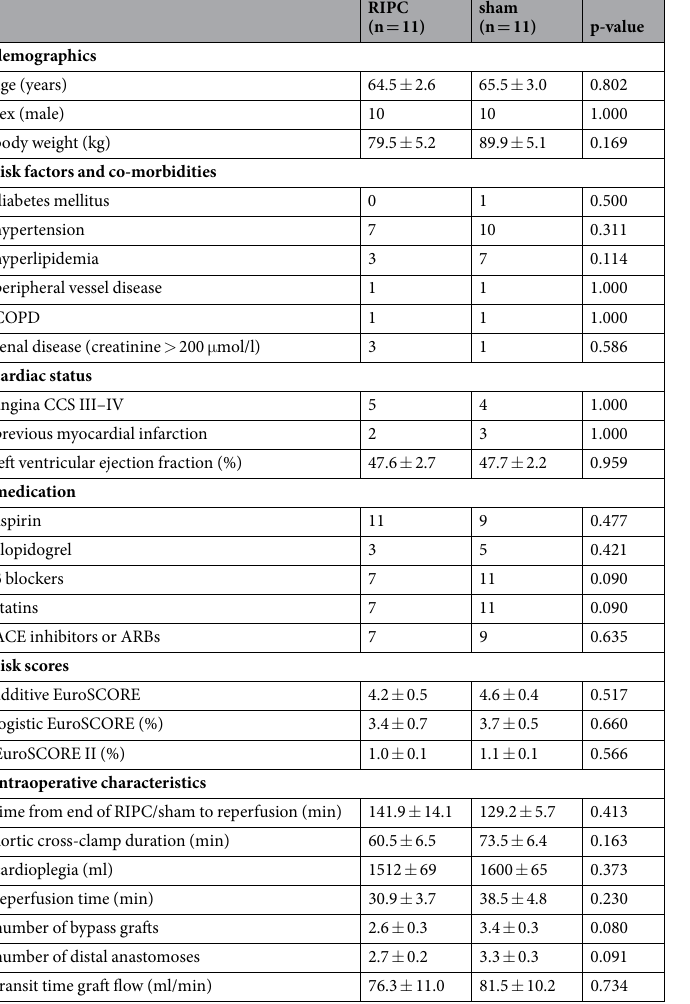
Table 1. Baseline and intraoperative characteristics of patients. Data are mean ± standard error of the mean or number. Patient baseline and intraoperative characteristics were compared using unpaired Student’s t-test (continuous data) and 2-tailed Fisher’s exact test (categorical data). Chronic obstructive pulmonary disease (COPD), Canadian cardiovascular society score (CCS), angiotensin-converting enzyme (ACE), angiotensin- II-receptor blockers (ARBs), European system for cardiac operative risk evaluation (EuroSCORE), remote ischemic preconditioning (RIPC). Reperfusion time: time from release of aortic cross-clamp to end of cardiopulmonary